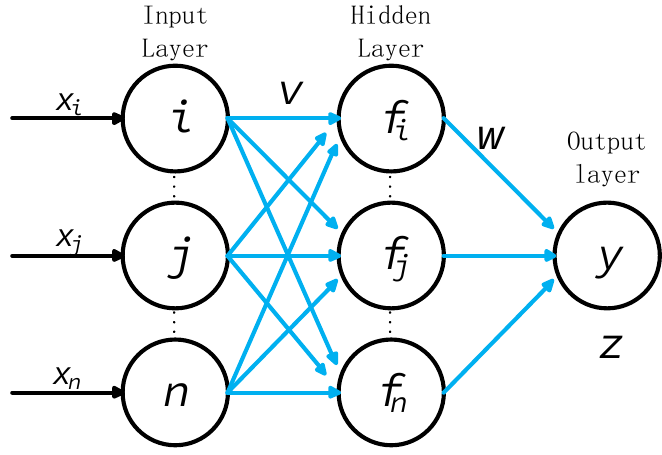
Figure 1. Schematic diagram of neural network architecture.